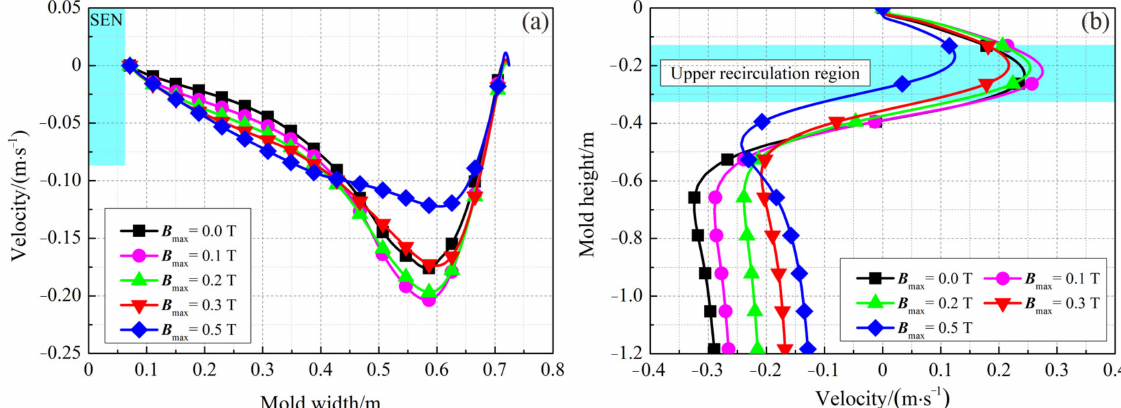
Figure 7. Velocity profiles in the mold with various magnetic flux densities: ( a ) steel–slag interface velocity ( Y = 0 m, Z = − 0.035 m) and ( b ) vertical velocity along mold height direction ( X = 0.695 m, Y = 0 m).